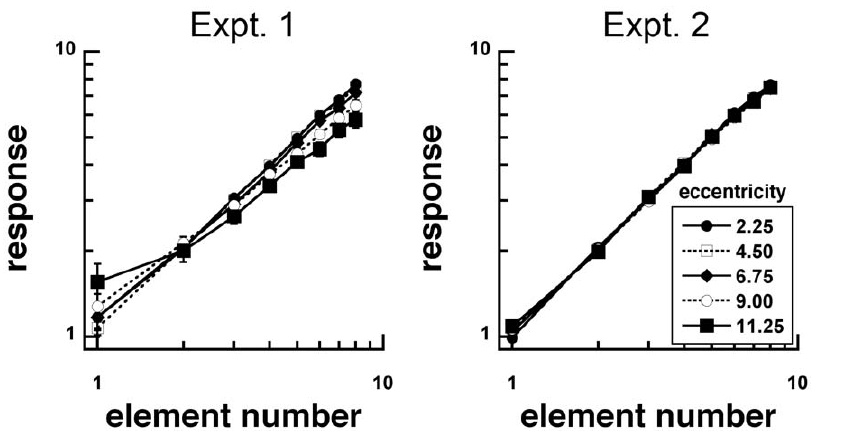
Figure 4. Mean response as a function of element number for stimuli with unscaled (Experiment 1) and scaled (Experiment 2) sizes. Response accuracy decreased as viewing eccentricity increased in Experiment 1, but not in Experiment 2. Response accuracy also decreased with increasing element number.